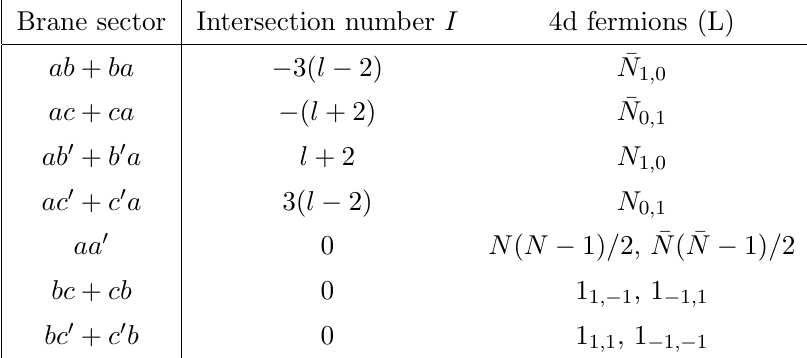
where branes b and 1